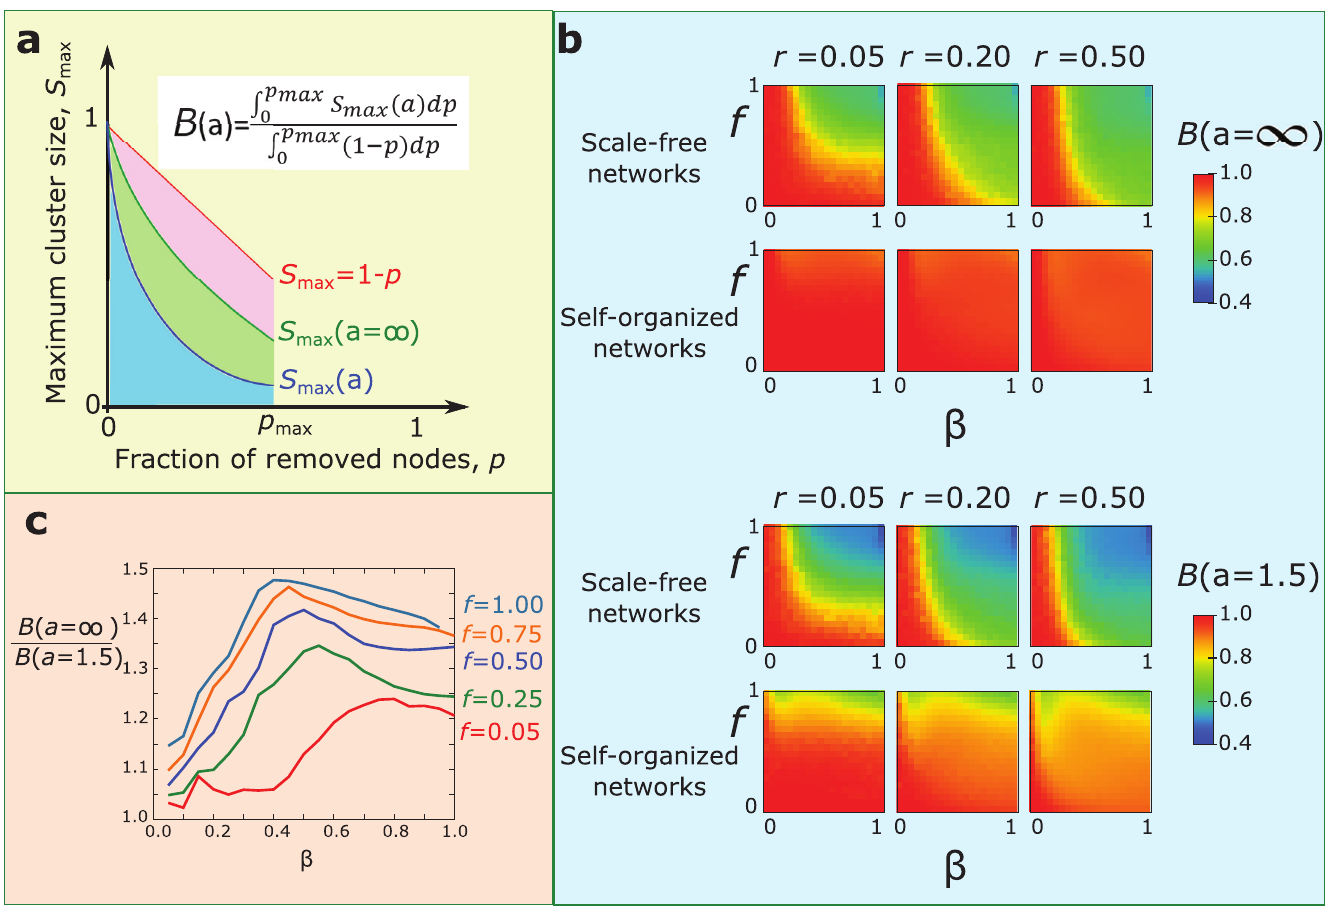
Fig 6. Structural impact of the epidemic process. (a) Calculation of the quantity B ( a ). For a given value of a we calculate the ratio of the area under the − p . (b) The values of B ( a ), calculated in scale-free and self-organized networks, as a S max curve over the area under the case of least possible damage 1 function of β and f . The top two rows correspond to a = 1 , and the bottom two rows to a = 1.5. (c) Comparison of the structural damage measured through the largest cluster size ( a = 1 ) vs the damage measured through limited-path-percolation ( a = 1.5). The ratio indicates that the largest cluster may overestimate the robustness of the social structure by a factor of up to 1.5.